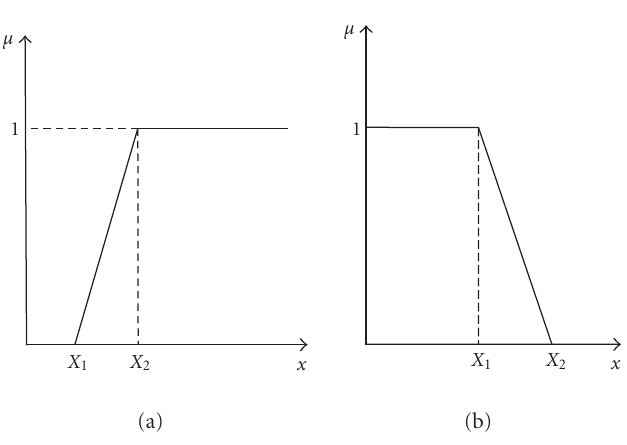
Figure 4.1. (a) Fuzzy set for large. (b) Fuzzy set for small or short.